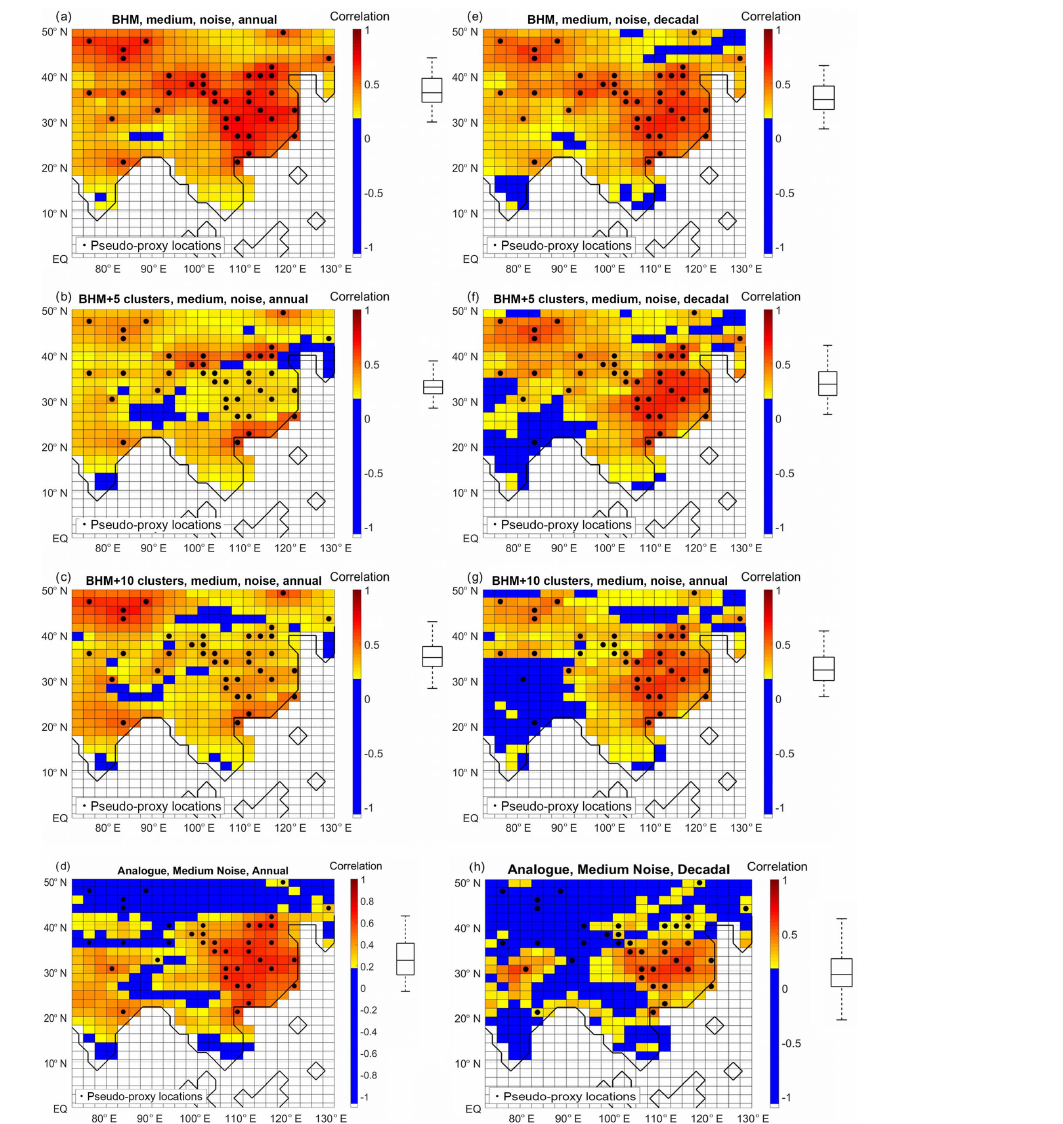
Figure 4. Correlation between target precipitation and different reconstructions, at each grid point. (a, b, c, d) Annually resolved data. (e, f, g, h) Decadally resolved data. (a, e) BHM. (b, f) BHM + 5Clusters. (c, g) BHM + 10Clsuters. (d, h) Analogue method. The boxplots (indicating median, 25%, and 75% percentiles and non-outlier limits) to the right of the colour bars show the distribution of the grid-point correlation coefficients. Black dots: pseudo-proxy